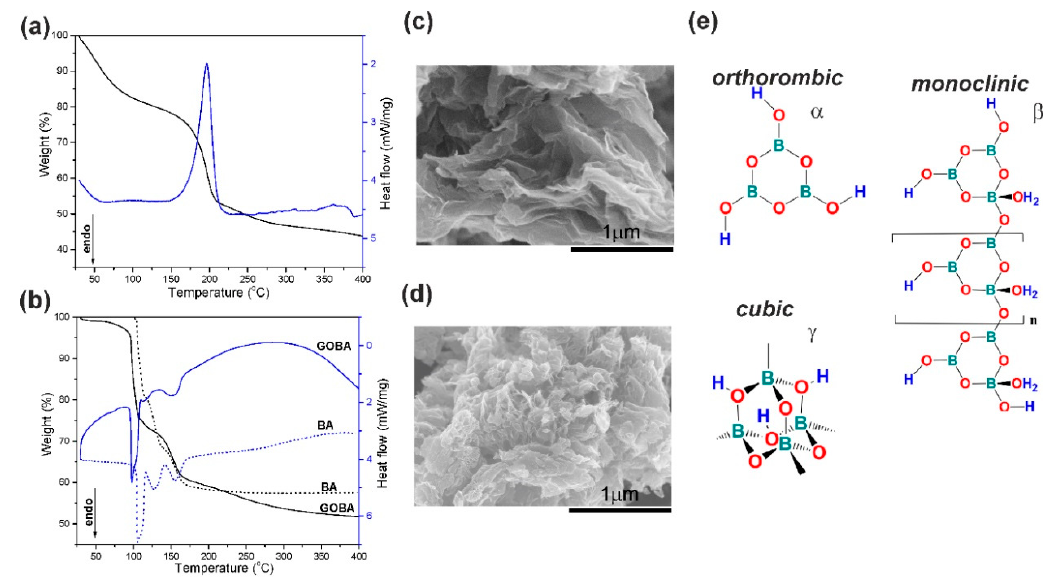
Figure 1. Thermogravimetric (TG) (black line)/differential scanning calorimetry (DSC) (blue line) thermograms obtained in the systems composed of boric acid (BA) and graphene oxide (GO): ( a ) pristine GO powder; ( b ) BA and precursor mixture of GOBA Scanning electron microscopy (SEM) images of rGO samples: ( c ) GOBA and ( d ) GO/T; ( e ) Representative structures of monotropic forms of HBO 2 .